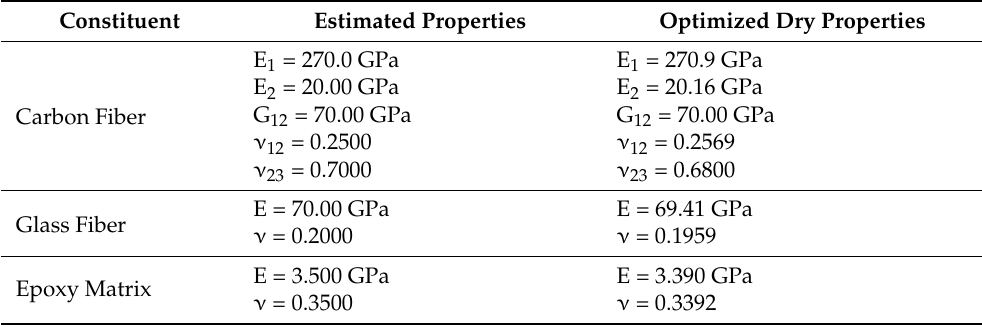
tion process, compared with values estimated from the